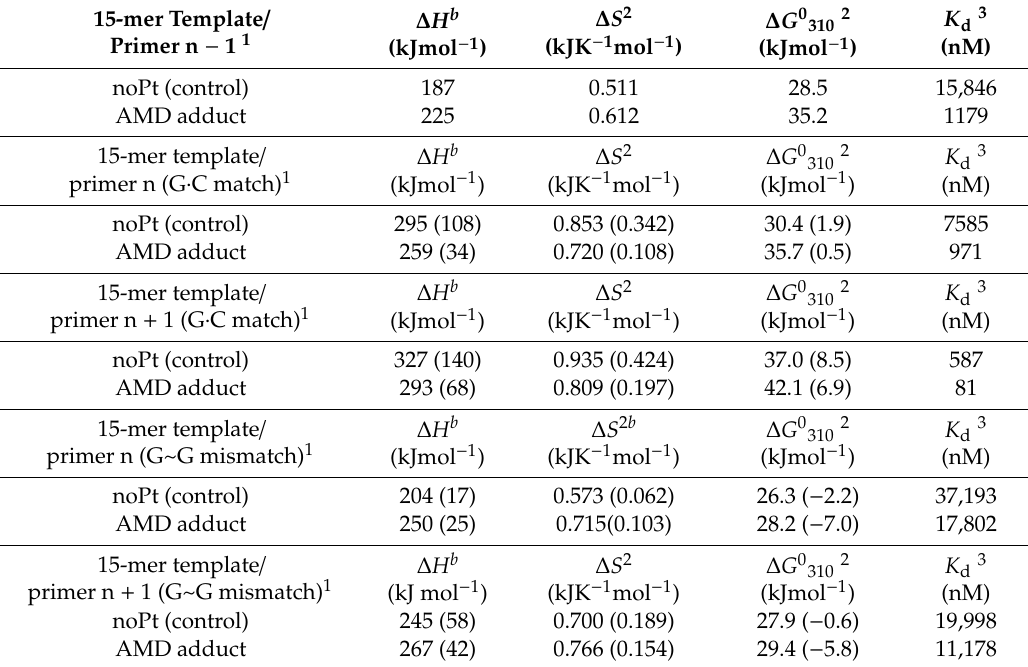
Table 3. Microscale thermophoresis (MST)-derived thermodynamic parameters for the dissociation (melting) of the duplexes: 15-mer template / primer n − 1, 15-mer template / primer n (G · C match), 15-mer template / primer n + 1 (G · C match), 15-mer template / primer n (G~G mismatch), and